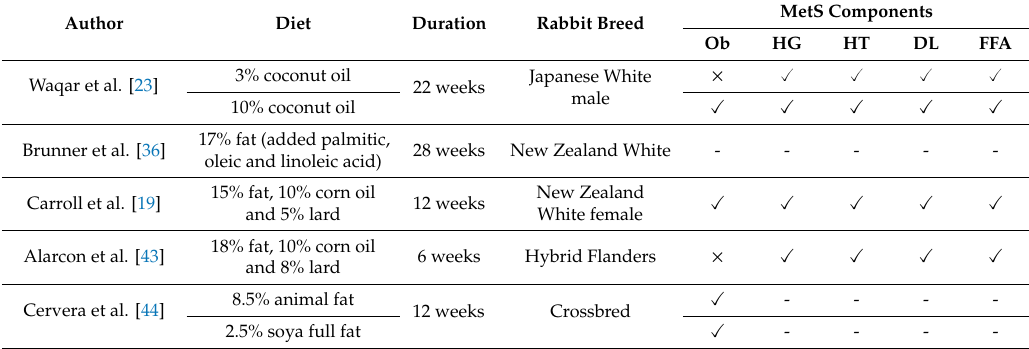
The symbol “ (cid:88) ” indicates the presence and “ × ” indicates the absence of the MetS components, while “-” indicates that the component was not evaluated in the study. Ob: obesity, HG: hyperglycemia; HT: hypertension, DL: dyslipidemia and FFA: free fatty